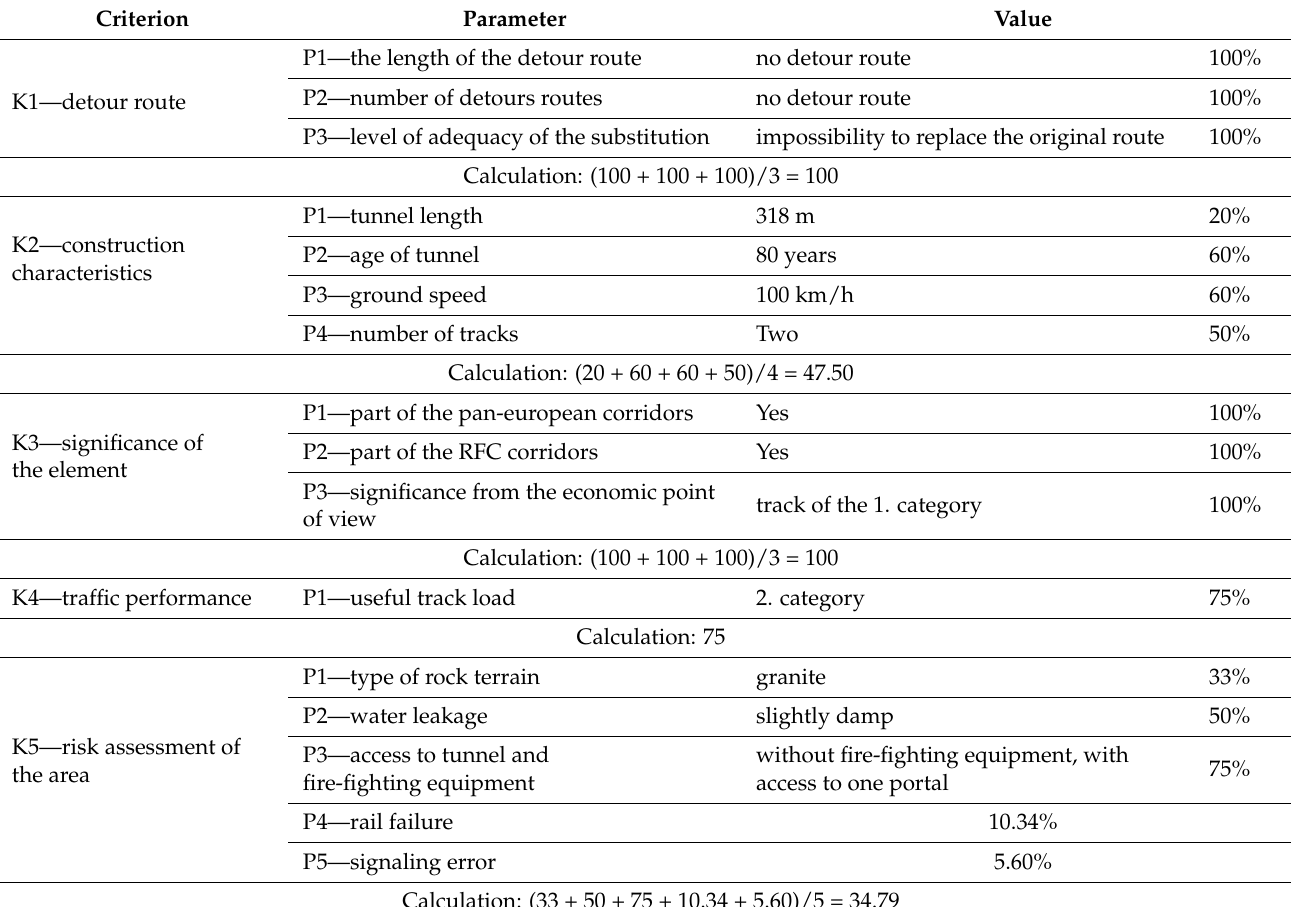
Table 15. Parameters and their Values of Streˇcno I